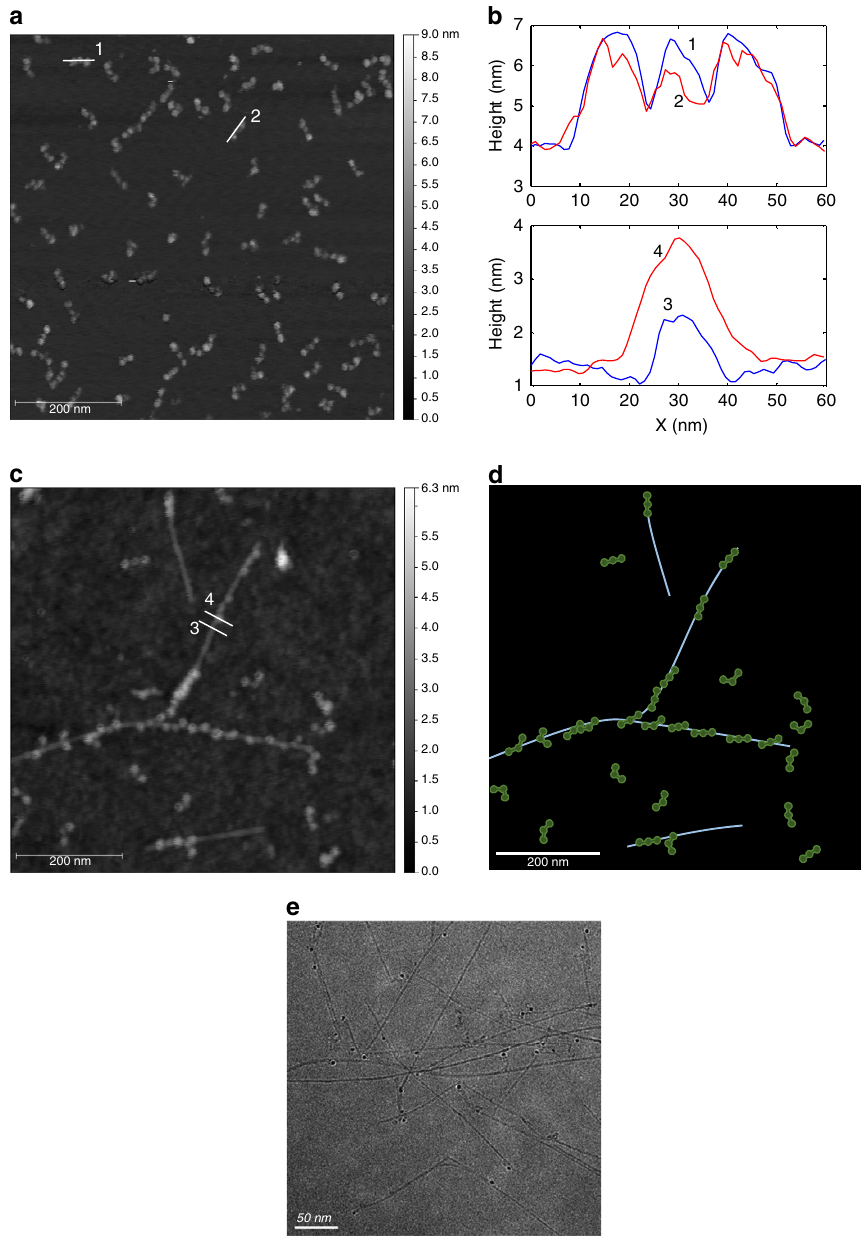
Figure 5 | High resolution microscopy of the SWCNT–fibrinogen interaction. ( a ) AFM image of fibrinogen molecules on MICA surface. Scale bar, 200nm. ( b ) Height profiles along the lines in the AFM images. ( c ) AFM of DPPE-PEG(5000)-SWCNTwith fibrinogen on a silicon wafer. Scale bar, 200nm. ( d ) Illustration of the SWCNT (blue lines) and fibrinogen molecules (green dumbbells) in panel c . ( e ) Cryo-TEM image of DPPE-PEG(5000)-SWCNTwith fibrinogen, showing individually suspended SWCNT and no bundling. The dark spheres are catalyst particles. Scale bar,